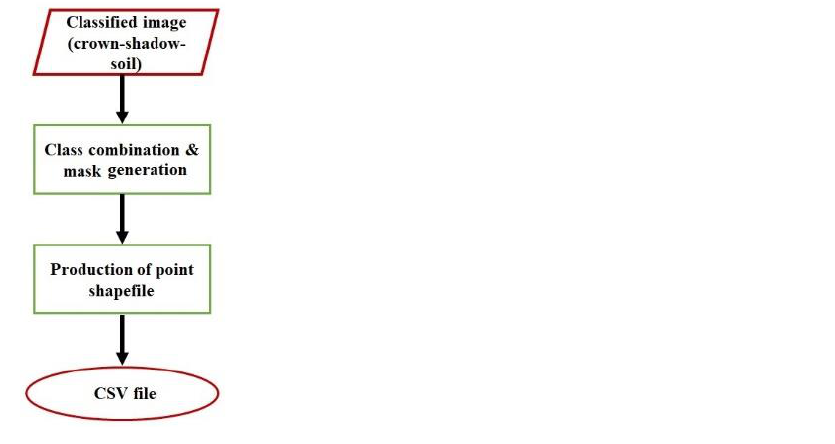
Figure 2. The multi-rotor DJI Mavic Pro drone and its flight plan ( a ), an example of orthophoto image (green band) ( b ).